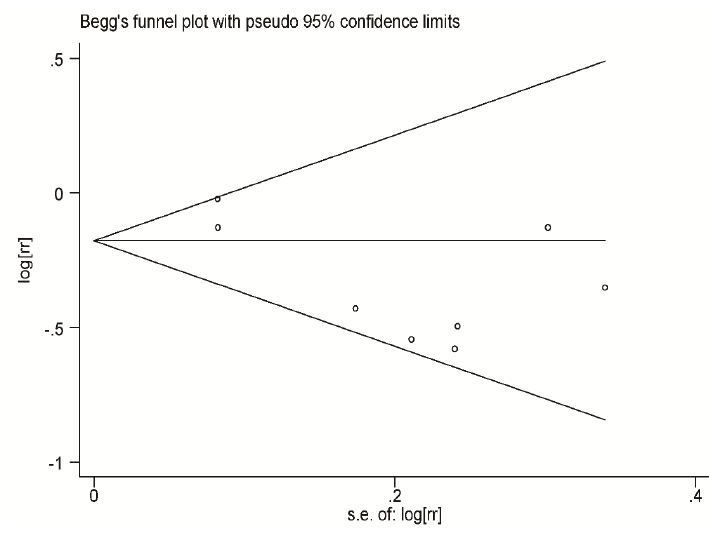
Figure 5. Funnel plot of fish consumption and risk of AMD in the evaluation of publication bias. No